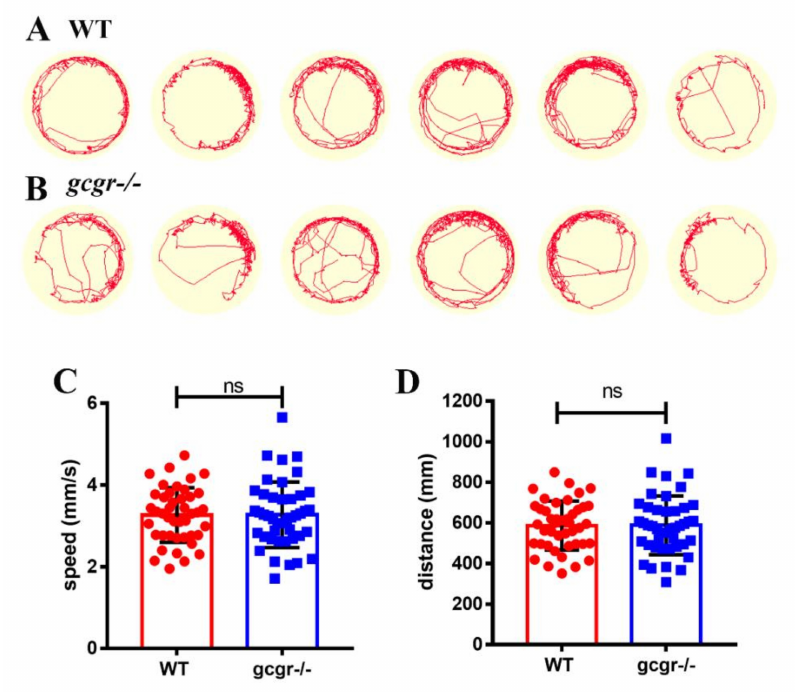
Figure 2. gcgr − / − mutant fish have similar physical activity to controls. ( A , B ) Representative images of activity tracks of six wildtype ( A ) and gcgr − / − ( B ) zebrafish larvae. Each image is the track of one larva recorded for 3 min. ( C , D ) The average swimming speed ( C ) and swimming distance ( D ) of wildtype and gcgr − / − zebrafish larvae. Ns: no